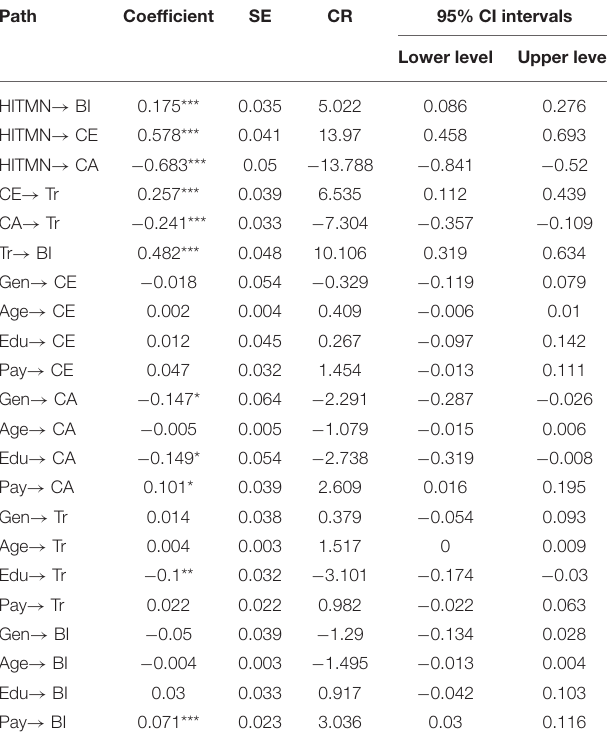
TABLE 3 | Results of path analyses.